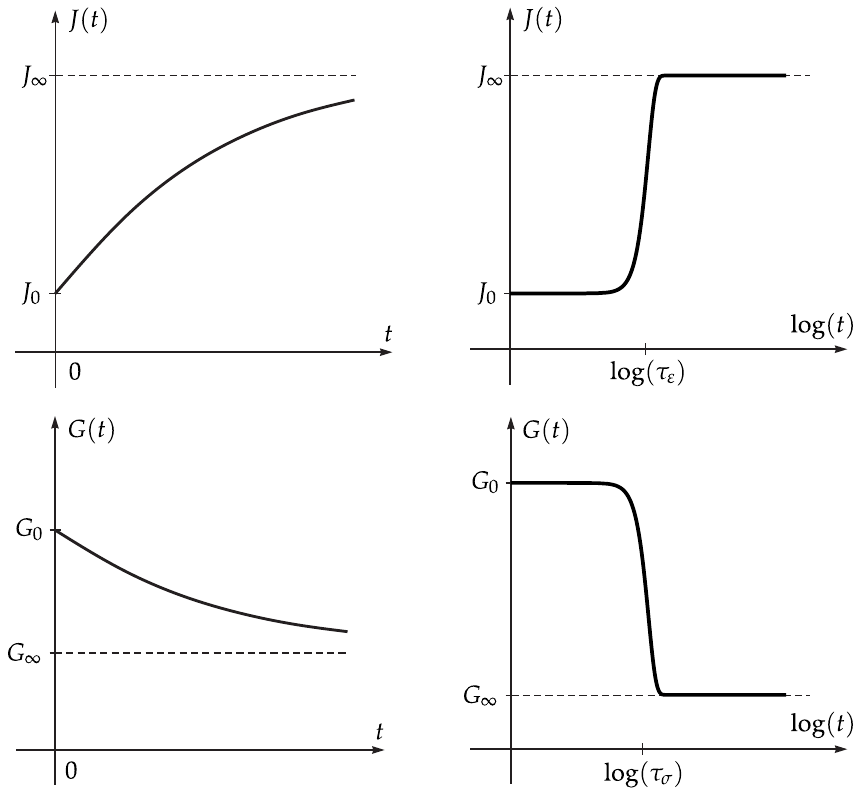
Figure 2. Creep and relaxation modeled by a single exponential function (Zener model). As mechanistic idea, the creep function (46) and the relaxation function (47) are as- sociated to a mechanical network model consisting of two springs (moduli E 0 , E 1 ) and a dashpot (viscosity η ), named Zener model [52], see Figure 3. Connecting Hooke’s law for a spring σ = E ε and Newton’s law for a dashpot σ = η ˙ ε , the Zener model is represented by an ordinary differential equation